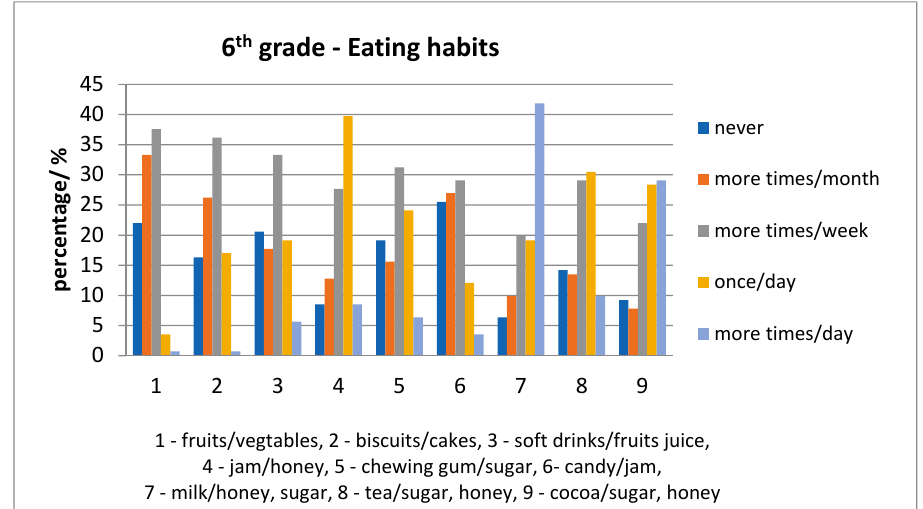
Figure 7. Eating habits in 6-year-old children.